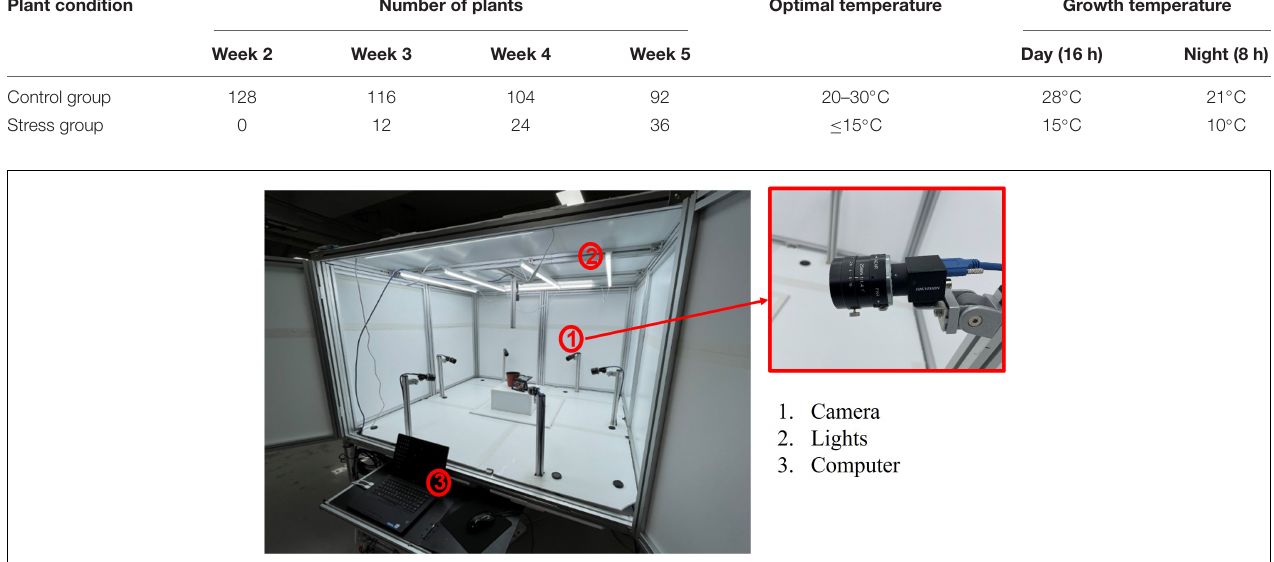
FIGURE 1 | System for data collection.